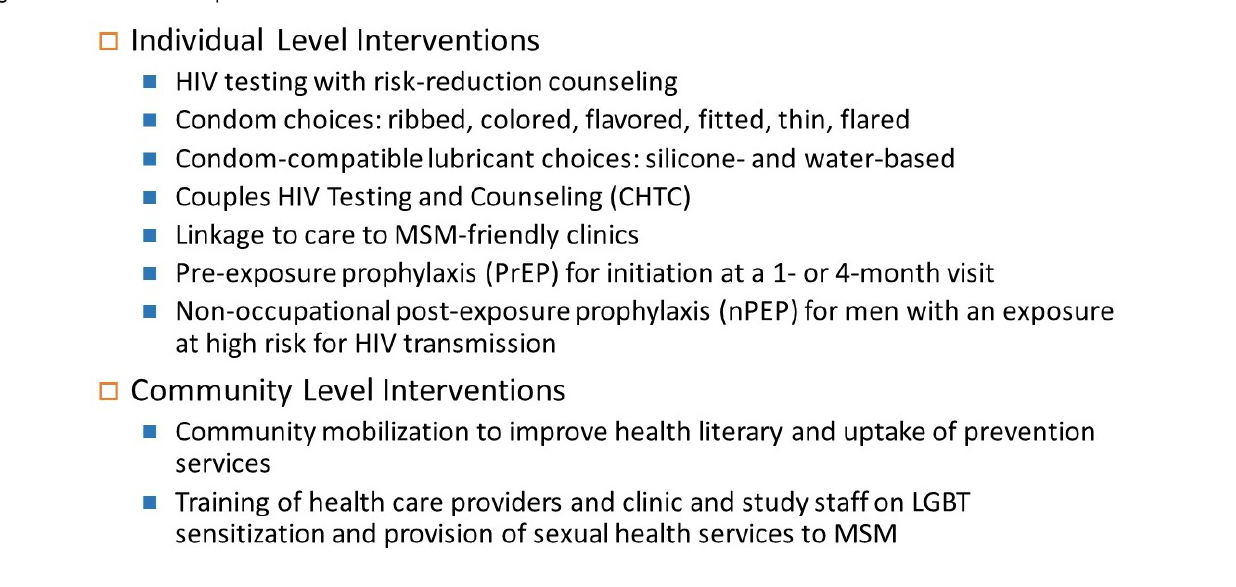
Figure 4. Intervention